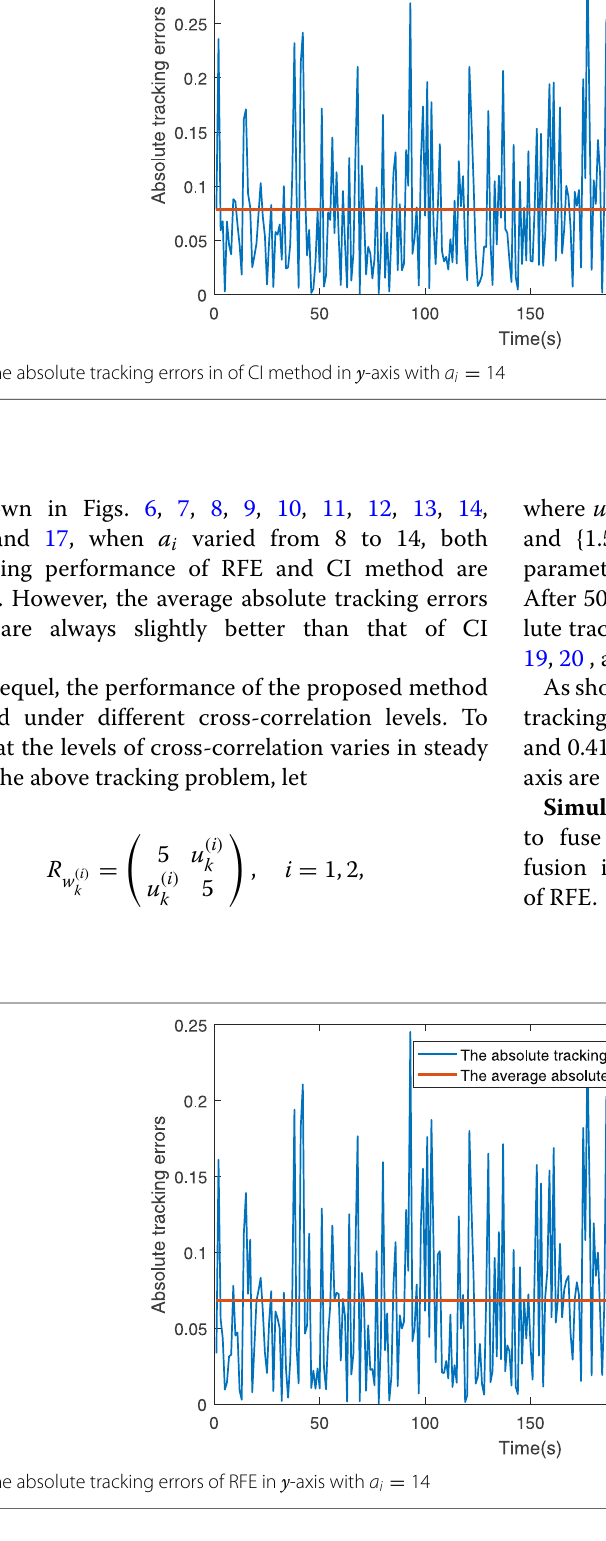
Fig. 17 The absolute tracking errors of RFE in y -axis with a i =